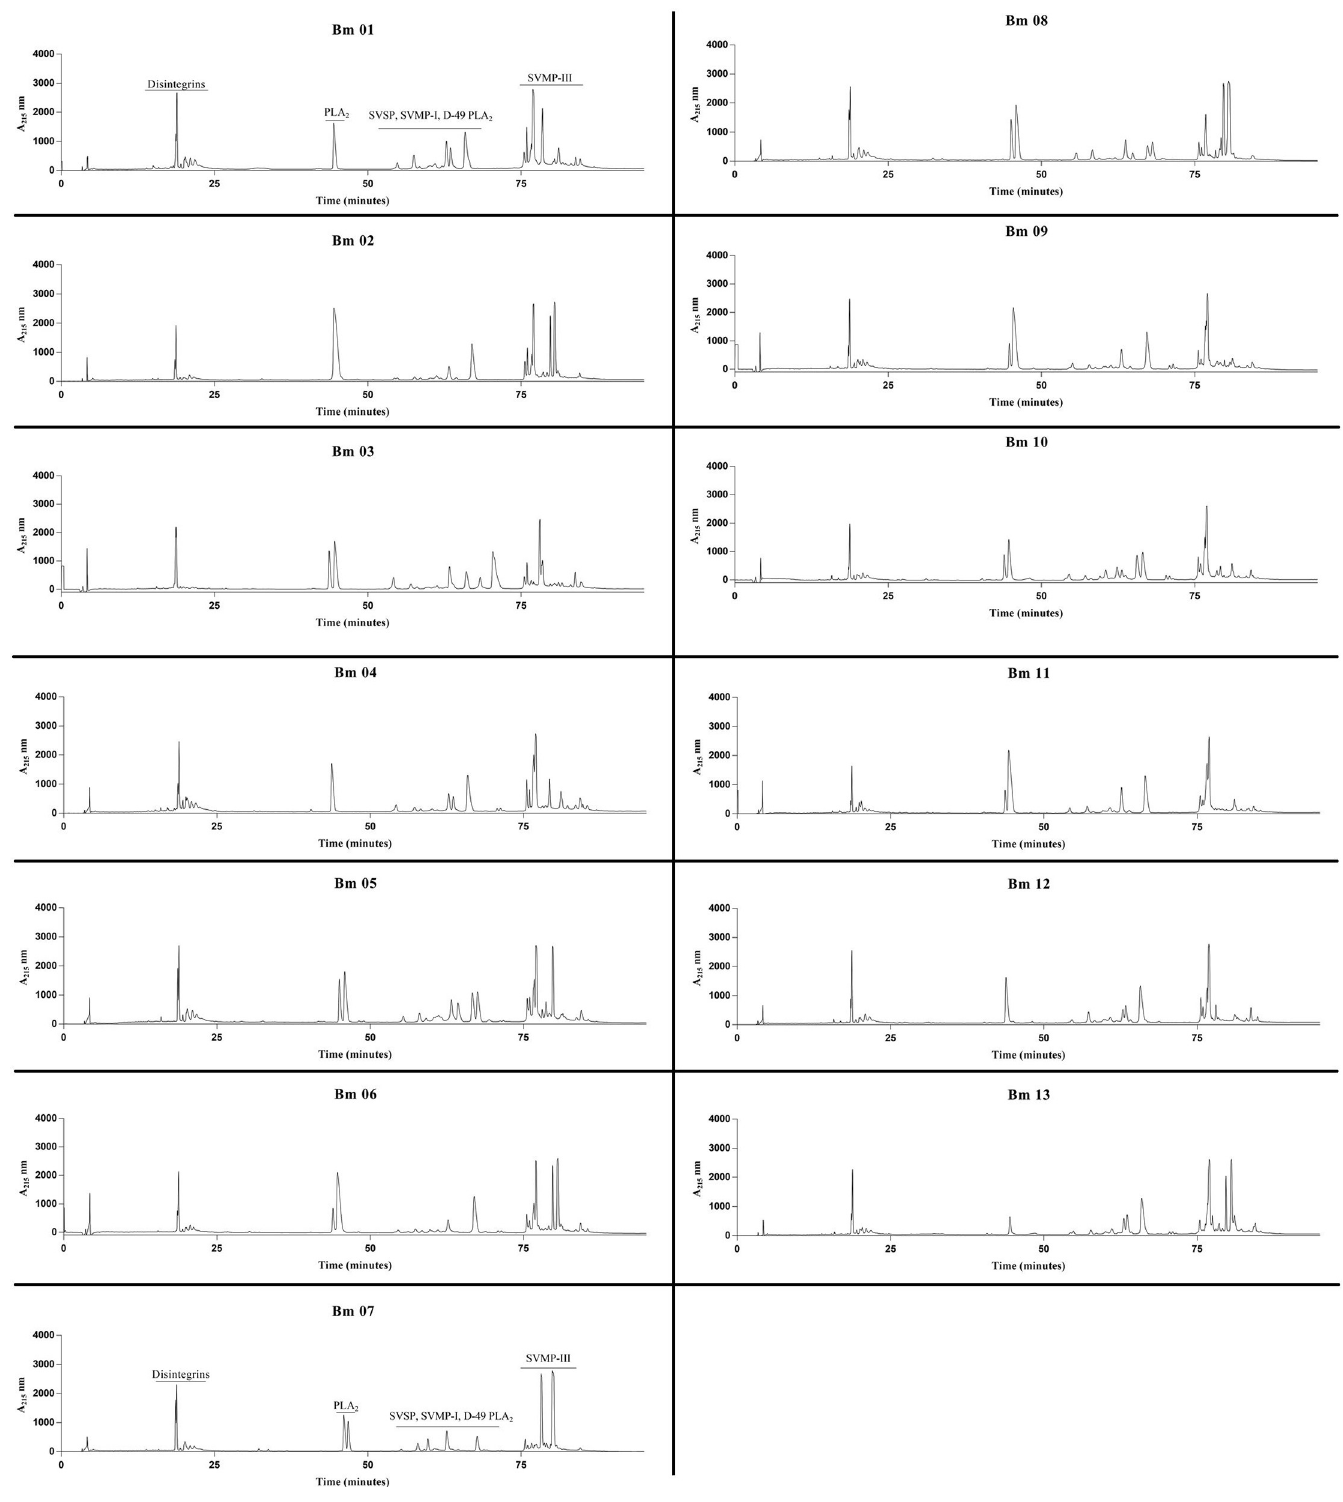
Fig 6. Elution profiles of B . moojeni venom proteins by RP-HPLC. Samples of 500 μ g of lyophilized venoms from specimens Bm1 to Bm13 were dissolved in 0.1% trifluoroacetic acid (TFA; solution A) and subjected to RP-HPLC in a C18 column. Elution was conducted at 1 mL/min by applying a gradient towards solution B (95% acetonitrile containing 0.1% TFA) as follows: 5% B for 5 min, 5–25% B for 10 min, 25–45% B for 60 min, 45–70% B for 10 min, 70–100% B for 10 min, and 100% B for 10 min. Absorbance was measured at 215 nm.